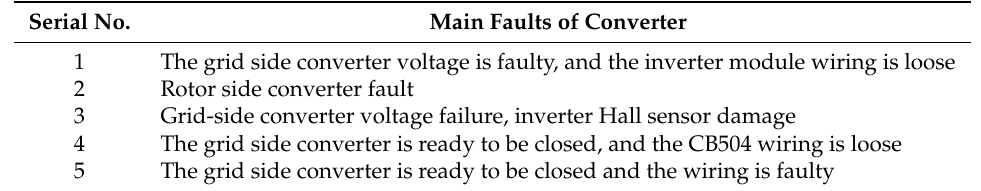
Table 4. Main faults of converter.